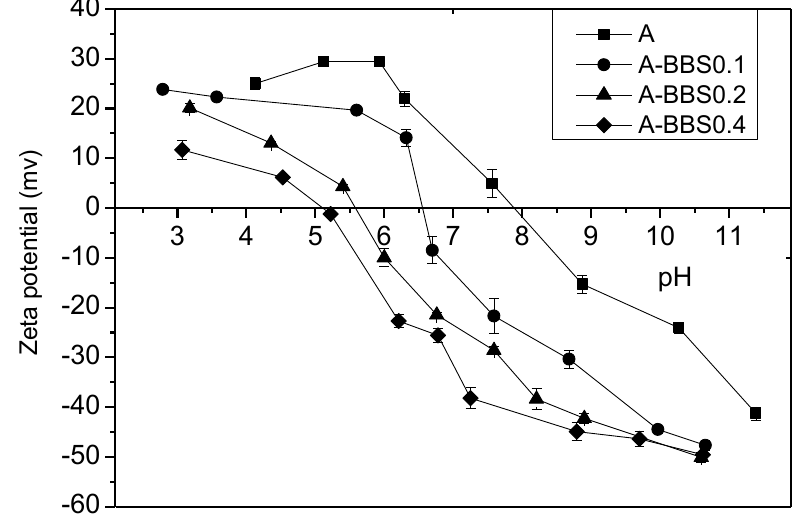
Figure 4. Zeta potential trends of A (squares), A -BBS0.1 (circles), A -BBS0.2 (triangles), and A -BBS0.4 (diamonds) as a function of pH.